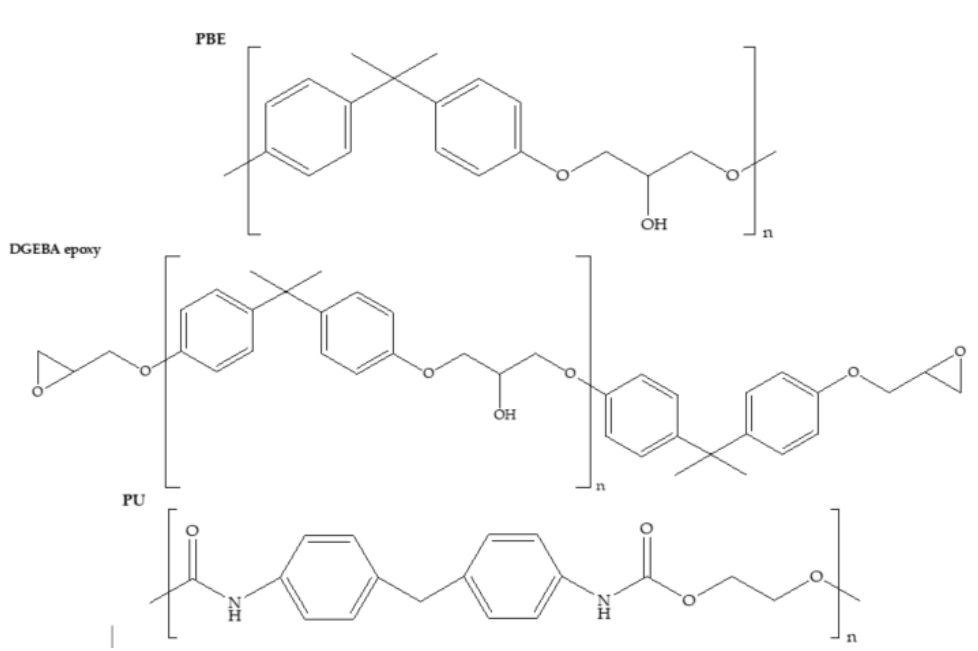
Figure 3. Chemical structures of thermosetting polymers and the abbreviations are explained in Table 2.